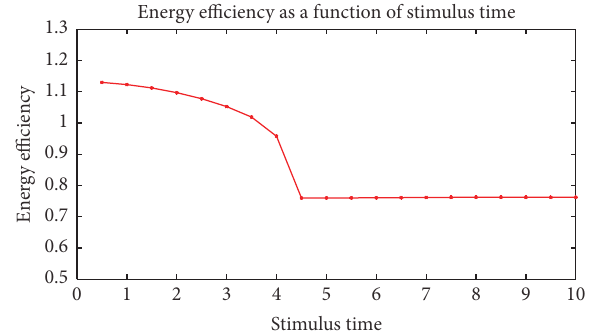
Figure 19: Energy efficiency as function of stimulus current dura-